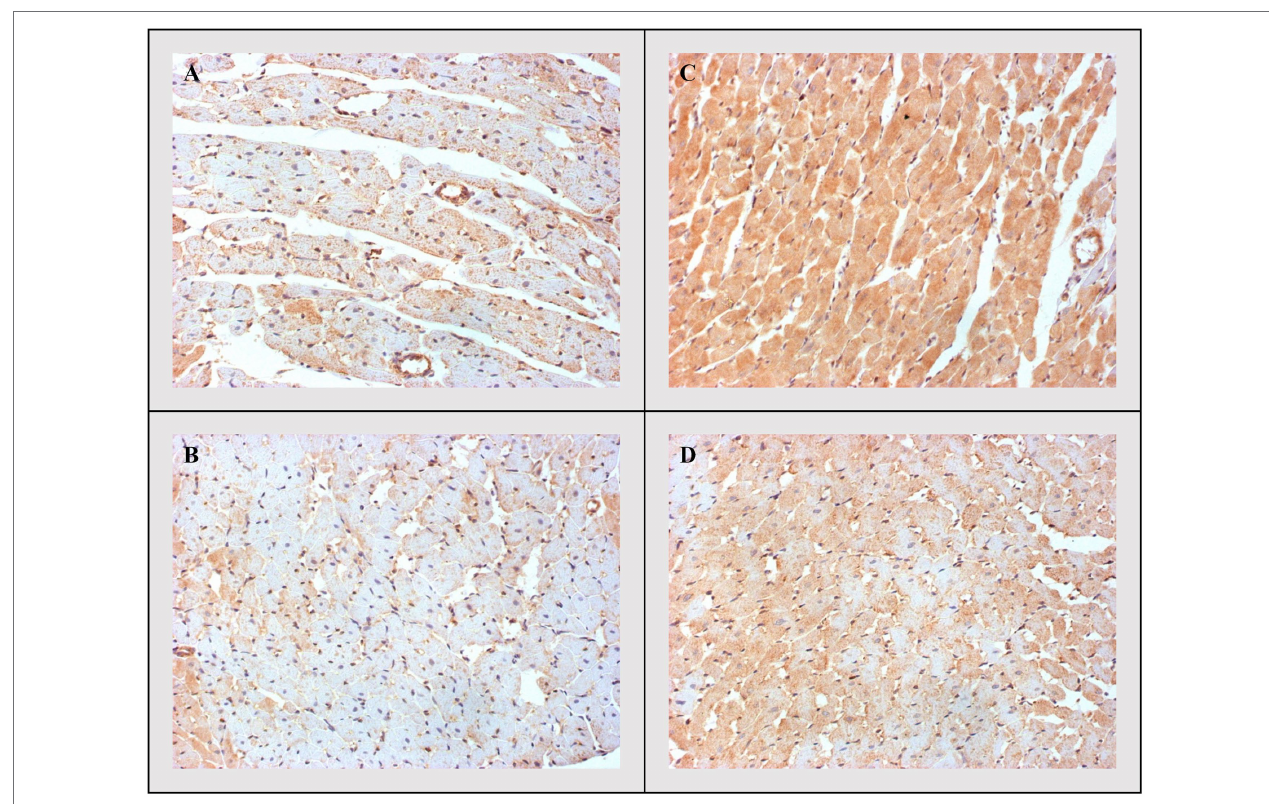
FIGURE 4 | Representative heart tissue sections of immunohistochemical staining of Bax. (A) CTRL, (B) THIA, (C) DOX, and (D) DOX + THIA. Original magnification 20 ×